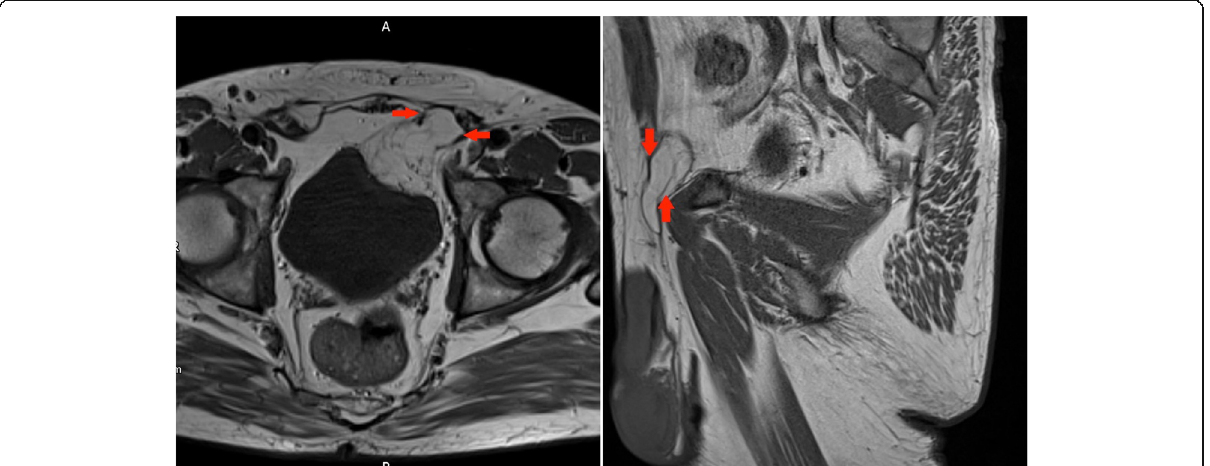
Fig. 4 Left panel: Axial T1-weighted MR image of the pelvis: a lipomatous lesion arising within the pelvis and indenting the anterior bladder wall is seen with herniation (red arrows) medial to the epigastric vessels in keeping with a direct inguinal hernia. Right panel: Sagittal T1-weighted MR image of the pelvis: red arrows outline the neck of the direct inguinal hernia containing a lipomatous lesion. The hernial sac content is bright on T1 in keeping with fat, the presence of internal septations and ‘ haziness ’ of the fat content suggest pathology other than a simple lipomatous lesion